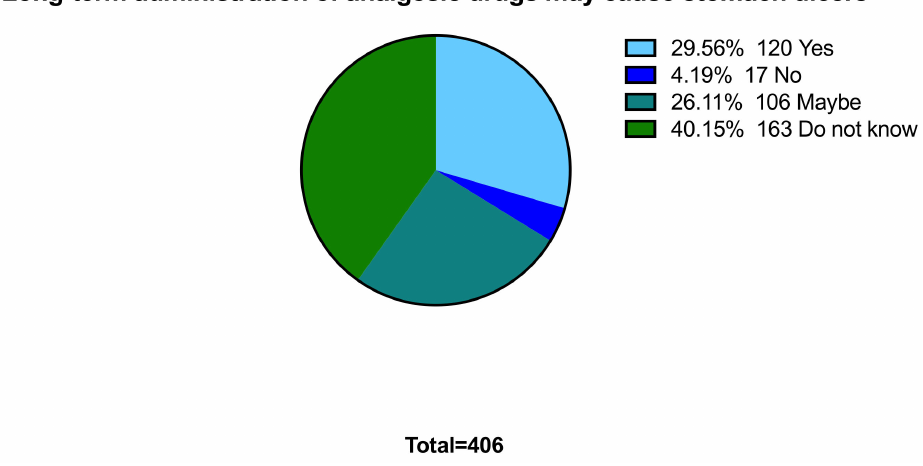
Figure 3. Long-term administration of analgesic drugs may cause stomach ulcers.